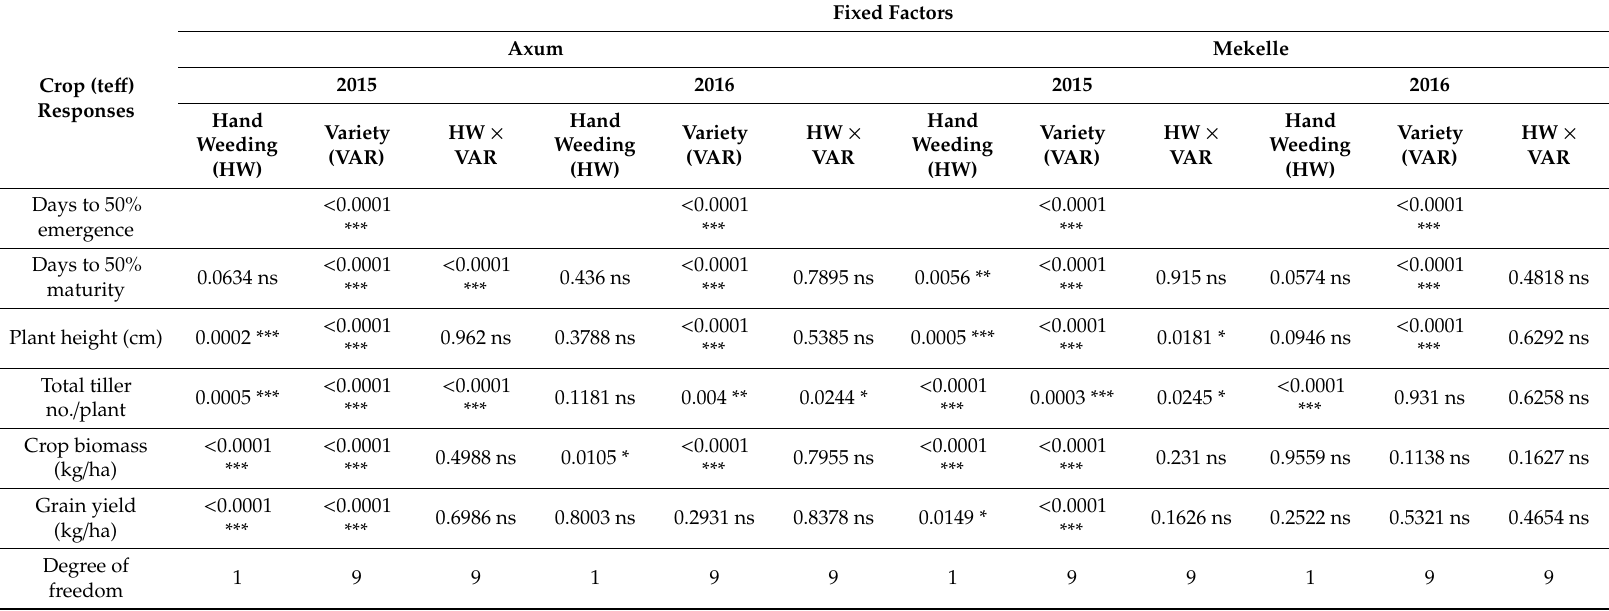
Table 5. ANOVA table with P-values for the main factors hand weeding and variety on di ff erent te ff